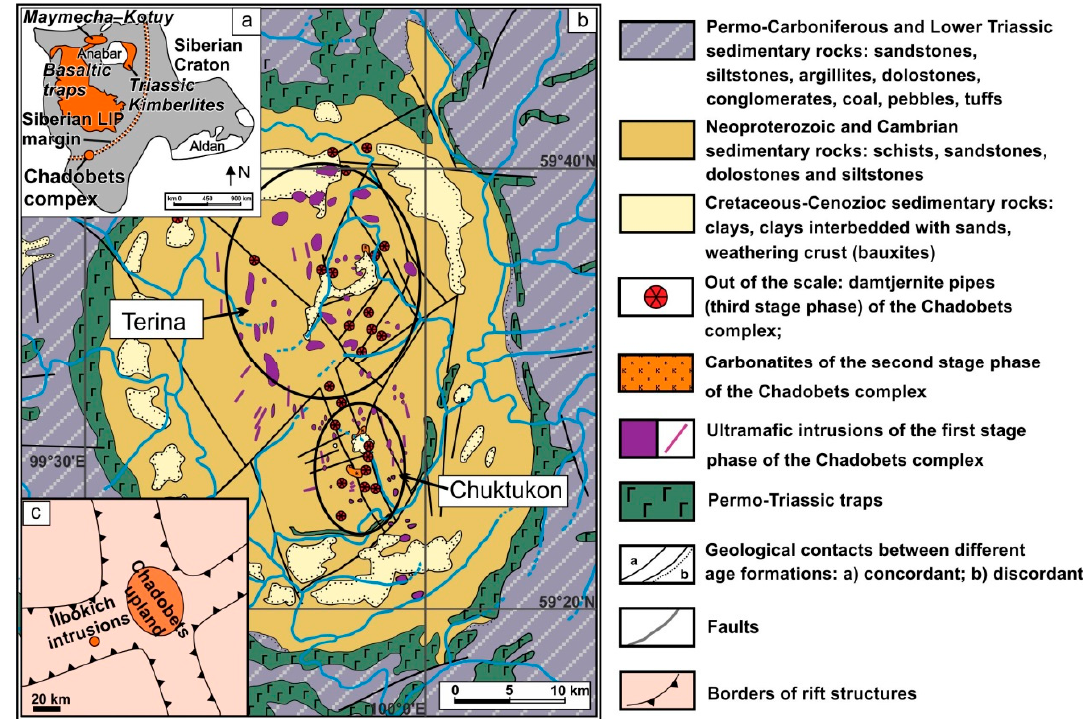
Figure 1. ( a ) Location of the Chadobets ultramafic lamprophyre (UML)–carbonatite complex within the Siberian Large Igneous Provence (LIP) on the Siberian Craton [24]. ( b ) Geological scheme of the Chadobets alkaline complex [7,25]. ( c ) Location of the Devonian Ilbokich complex [26]. UMLs of the first phase form dyke swarms and sills (ranging in size from 1–3 up to 120 m) [7,25,28–30]. The alkaline intrusions have sharp contacts with country rocks and they are distinguished by a banded structure. The carbonatite bodies are small stocks (up to 2.5 × 1.5 km),